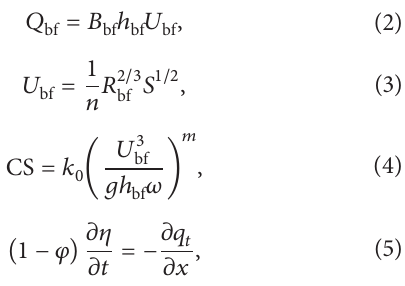
while the annual peak sediment discharge (daily peak data) 3 was 653 and 330 m /s,